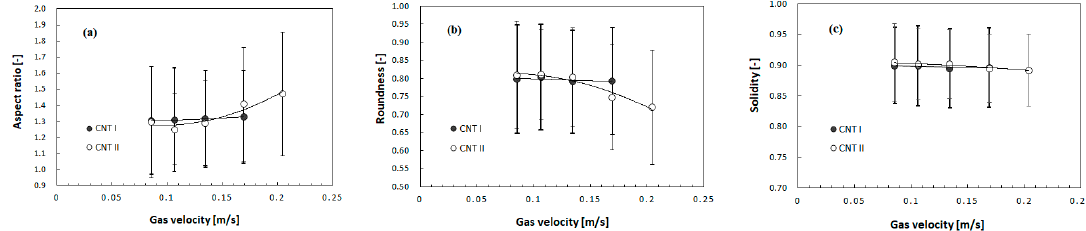
Figure 8. Effect of gas velocity on aggregates shape factor. ( a ) aspect ratio, ( b ) roundness, ( c ) solidity.